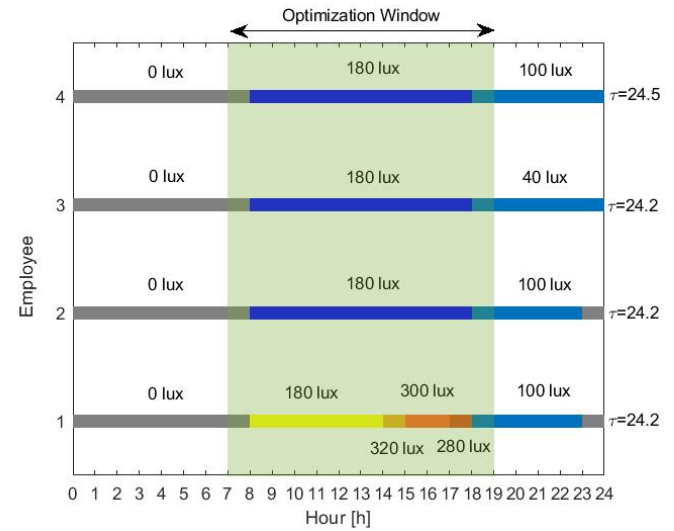
Figure 4. Lighting profile for every employee (1–4) input to the circadian pacemaker. We considered that light can be tuned (optimized) during the office hours (shaded area).